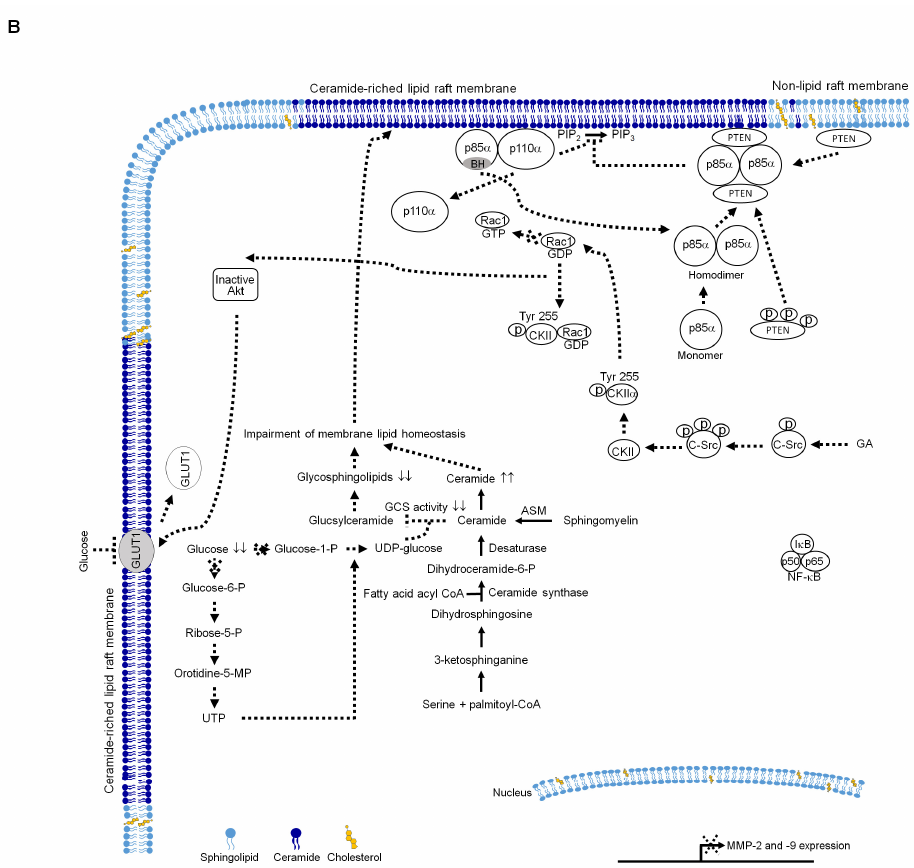
Figure 9. A molecular model for the induction of the inhibition of tongue squamous carcinoma (TSC) cell invasion by gallic acid (GA). ( A ) The selective interaction of clustered phosphatidylinositol 3-kinase (PI3K)-GTP-Ras-related C3 botulinum toxin substrate 1 (Rac1)-protein kinase B (Akt) signaling molecules in the lipid raft membranes constitutes a central element in the regulation of the lipid homeostasis of lipid raft membrane to promote cell invasive activity by enhancing lipid raft-associated glucose transporter-1 (GLUT-1)-mediated sphingolipid synthesis in response to survival signals. ( B ) Under the condition of cellular GA uptake, GA triggers cellular-Src (c-Src) activation to promote the Tyr 255 phosphorylation of casein kinase 2 α (CK2 α ), thus inducing the formation of inactive Rac1–p-CK2 α (Tyr 255) complexes and thereby disturbing the lipid raft membrane localization and full activation of Akt. The resultant attenuated Akt failed to modulate the lipid raft membrane-stabilizing activity of GLUT-1, leading to the loss of GLUT-1-dictated sphingolipid synthesis and glucosylceramide synthase activity (GCS) activity, which in turn raises ceramide level to create the ceramide-rich lipid raft membranes. The generation of the ceramide-rich lipid raft membranes impairs compartment-specific localization of lipid raft-associated PI3K molecules, leading to the formation of p110 α -free p85 α -unphosphorylated phosphatase tensin homolog deleted on chromosome 10 (PTEN) complexes in the lipid raft membranes. The resultant lipid raft membrane-associated p85 α –PTEN complexes can negatively regulate Akt activity by dephosphorylating the 3-position of phosphatidylinositol-3,4,5-trisphosphate (PIP 3 ) to PIP 2 . Dysregulation of lipid raft-associated PI3K-Rac1-Akt signaling was accompanied by attenuation of nuclear factor-kappa B (NF- κ B) regulated matrix metalloproteinase-2 (MMP-2) / -9-mediated cellular